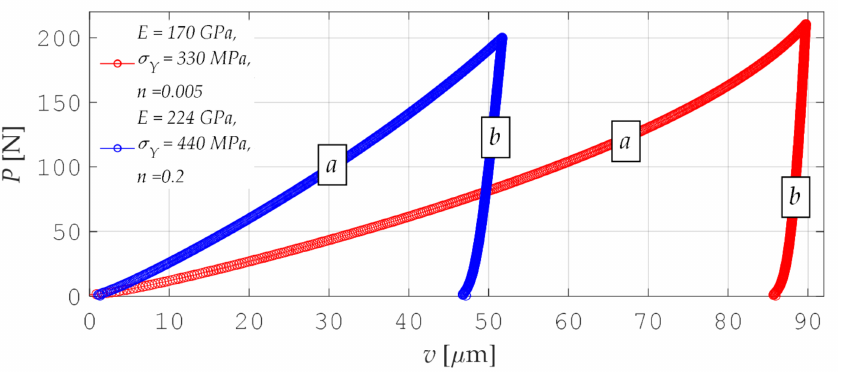
Figure 6. Example diagrams of indentation curves and their approximation functions (the letters a and b denote separate branches of one diagram).